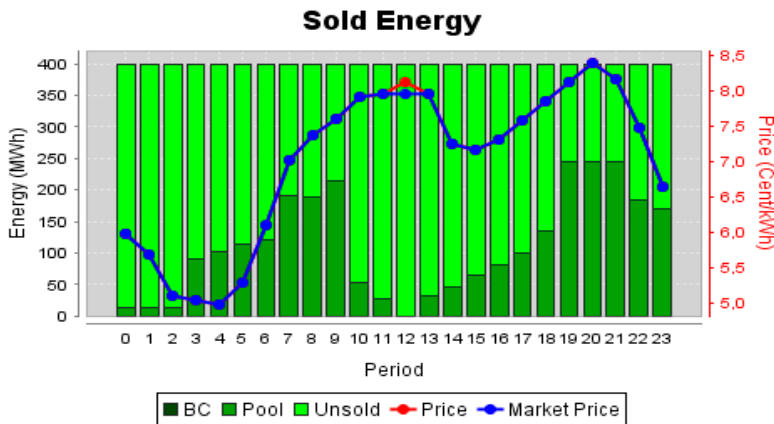
Figure 15. Energy sold on the market not considering the steam sale.